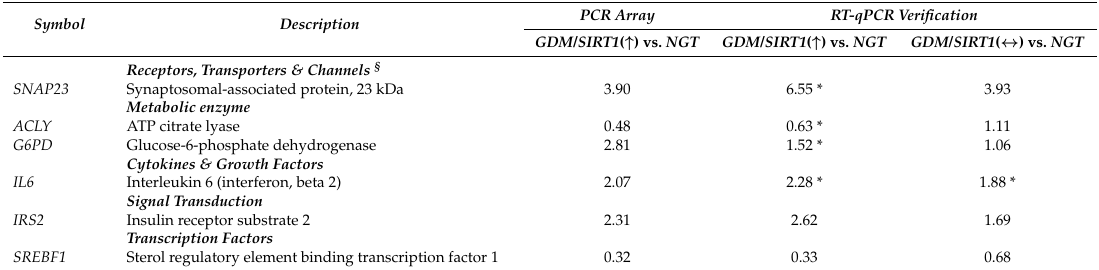
Table 5. Comparison of differences in gene expression between GDM and NGT for each of the six genes, as indicated by PCR array and RT-qPCR verification.